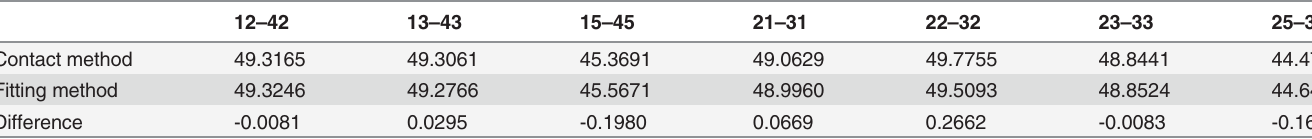
Table 4. Measurement results of the straight-line distance at the Z-axis (unit: